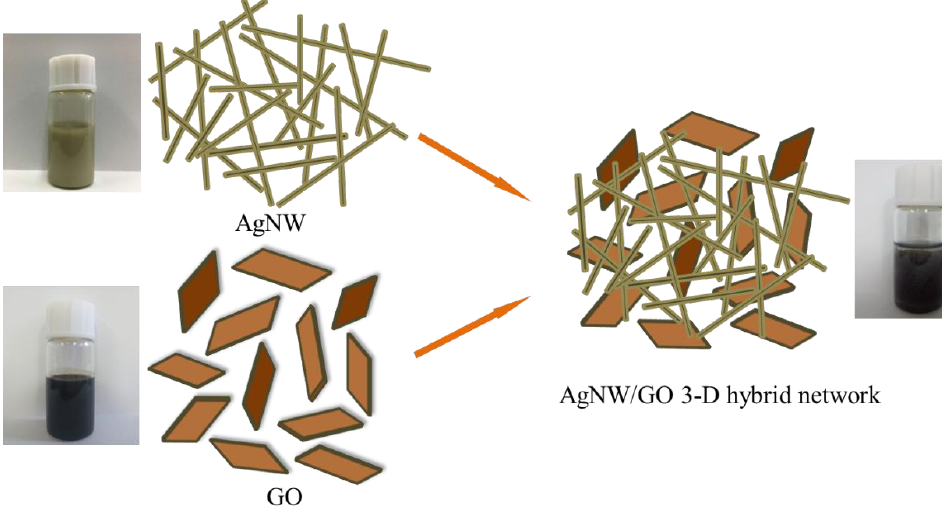
Scheme 1. Schematic illustration of AgNW / GO hybrid preparation